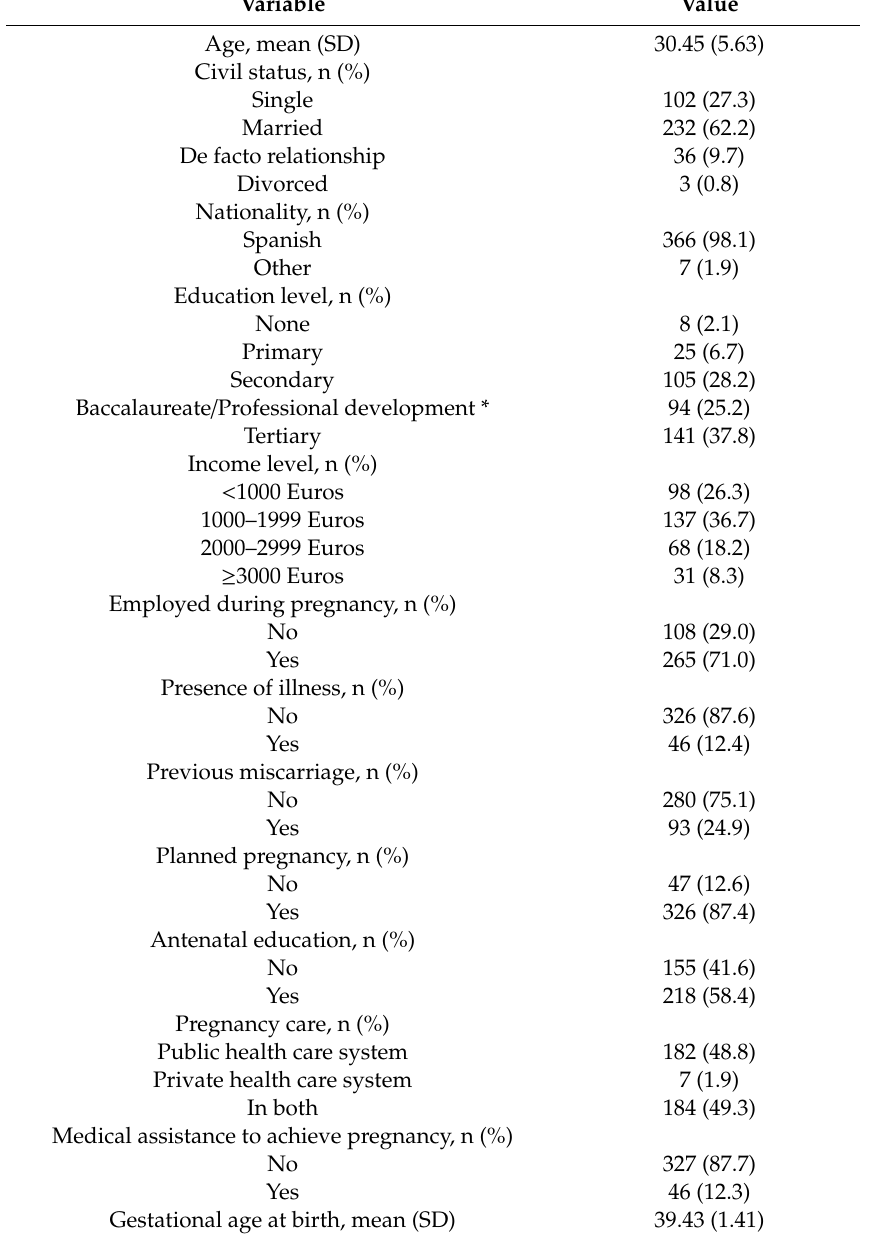
Table 1. Characteristics of the study population (n =